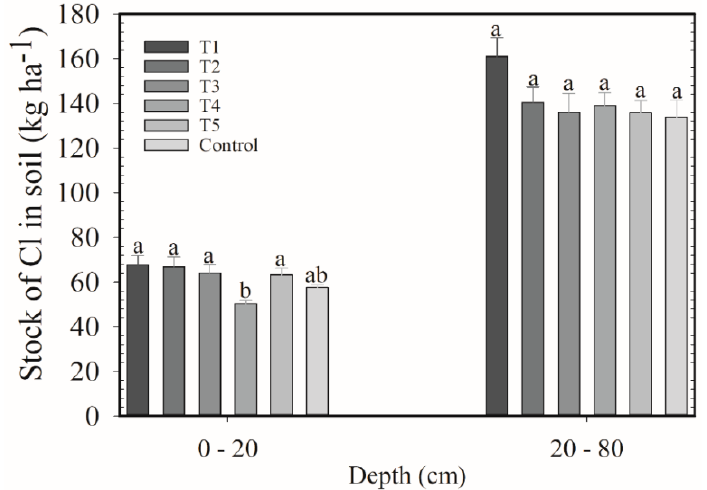
Figure 1. Stocks of Cl in the 0-20 and 20-80 cm layers after application of KCl and K 2 SO 4 blends as cover fertilization on coffee plants. 2018/2019 harvest. Means followed by the same letter in the column do not differ according to Tukey’s test ( p < 0.05). Vertical bars indicate the standard error of the mean ( n = 4). T1: 100% KCl; T2: 75% KCl + 25% K 2 SO 4 ; T3: 50% KCl + 50% K 2 SO 4 ; T4: 25% KCl + 75% K 2 SO 4 ; T5: 100% K 2 SO 4 ; control did not receive K 2 O.